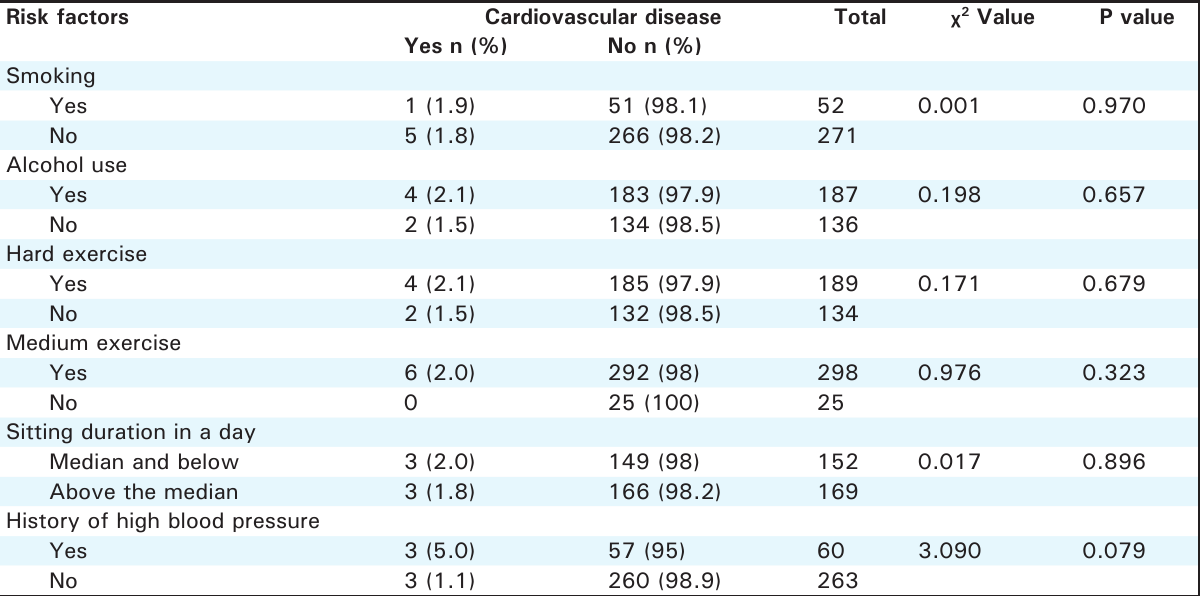
Table 4. Association of the risk factors forcardiovascular diseases among government